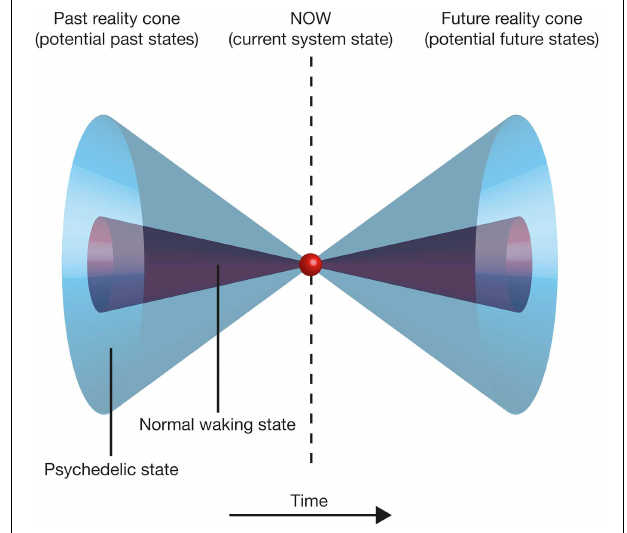
FIGURE 8 | Moving backward or forward in time from the current state of the complex, the number of potential states increases, producing a double “reality cone” extending into the past and the future. The area of the circular section at each time point represents the number of potential states. Psychedelic drugs increase the number of potential past and future states, expanding the reality